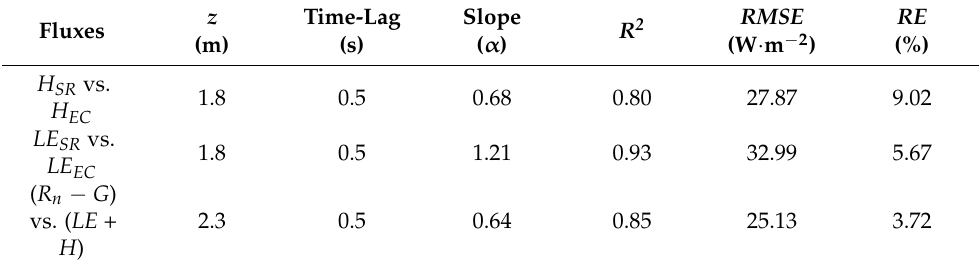
Figure 5. Half-hourly regression analysis between H SR and H EC . Table 1. The regression statistics between the half-hourly dataset.